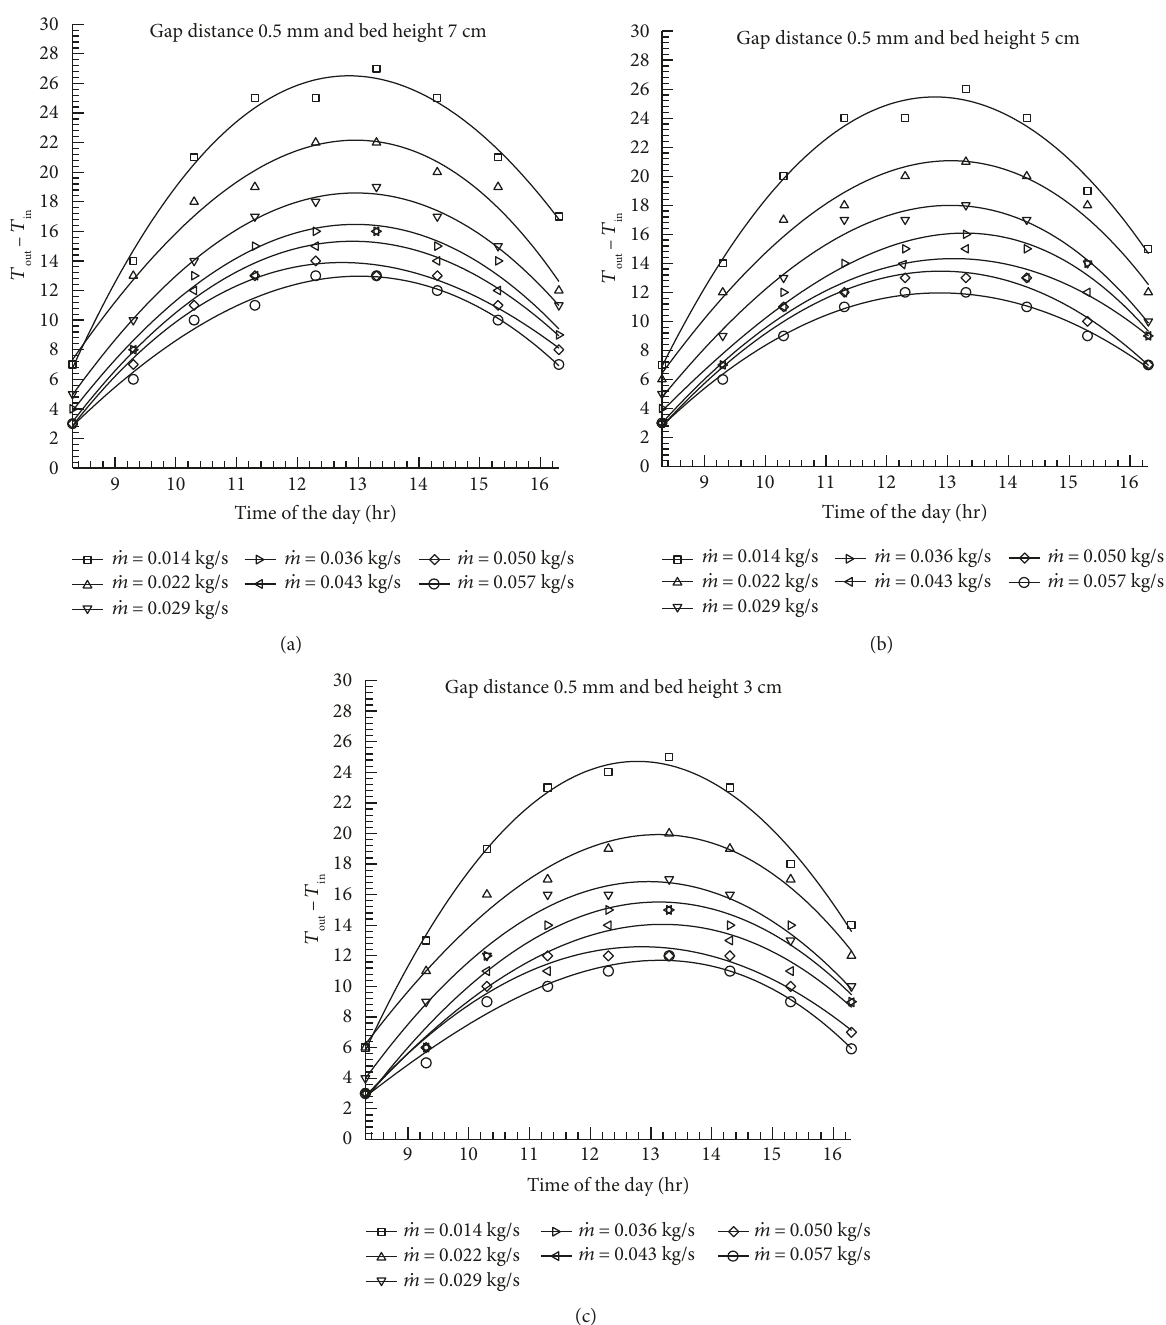
ff erent mass fl ow rates m and three di ff erent bed heights